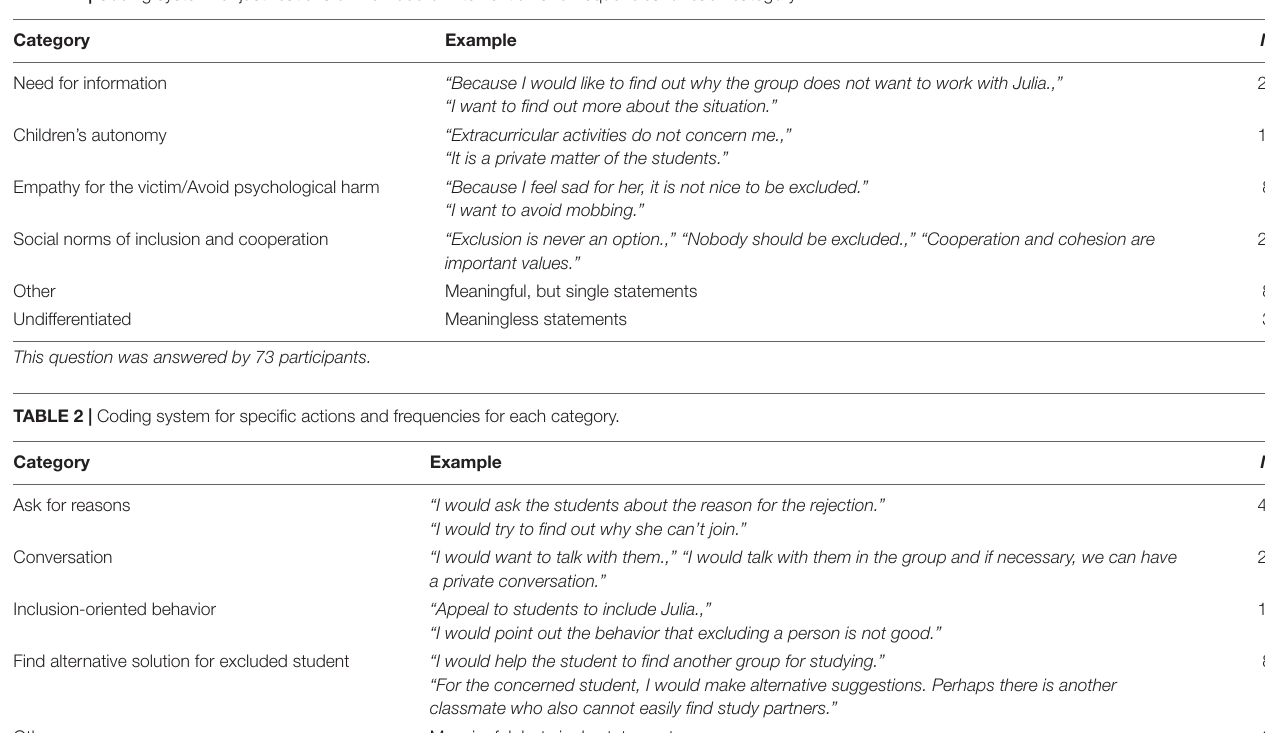
TABLE 1 | Coding system for justifications of likelihood of intervention and frequencies for each category.